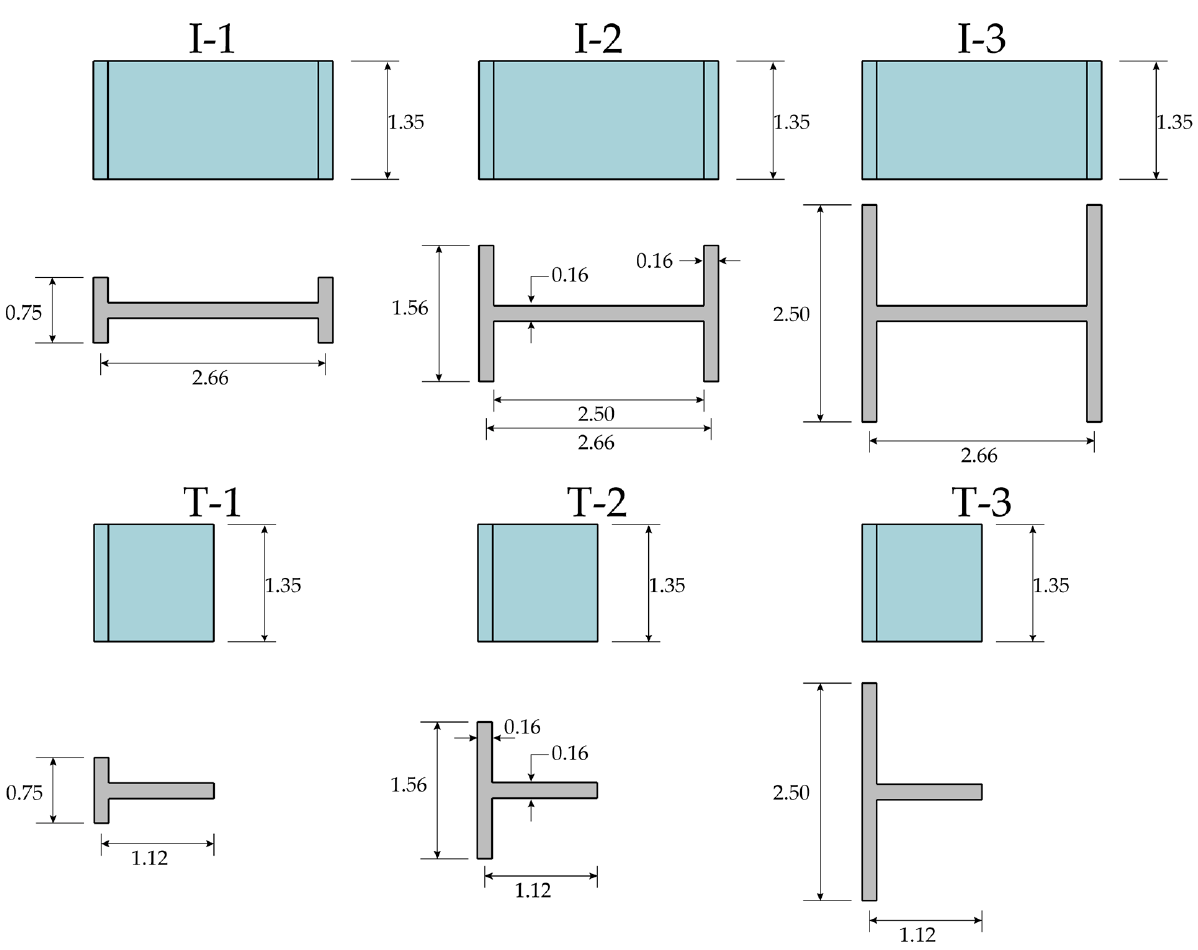
Figure 3. Case study structures: I- and T-shaped flanged sections with varying lengths of the flange (in meters).